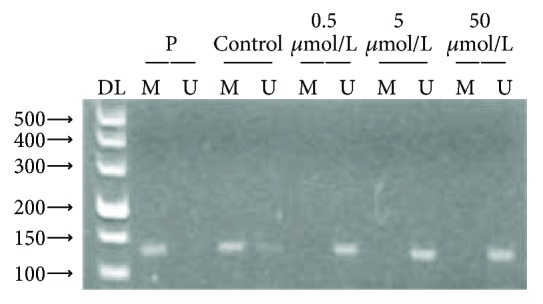
Demethylation of Wnt5a by different concentrations of 5-AzA-CdR in the SKOV3 cell line. DL500: DNA marker; P: positive control M: methylation; U: unmethylated.